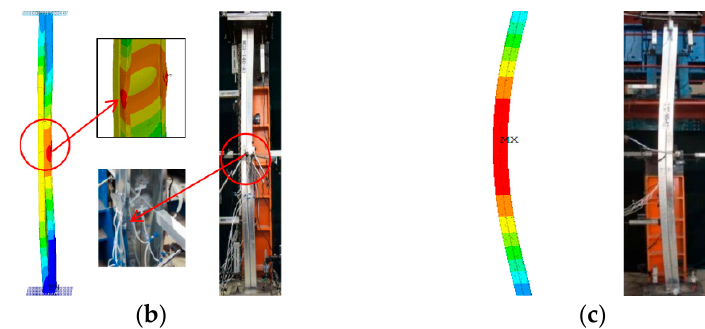
Figure 6. Comparisons of the failure modes of the combined columns ( a ) SC-90-A2; ( b ) MC-140-A1; ( c ) LC-90-A2.